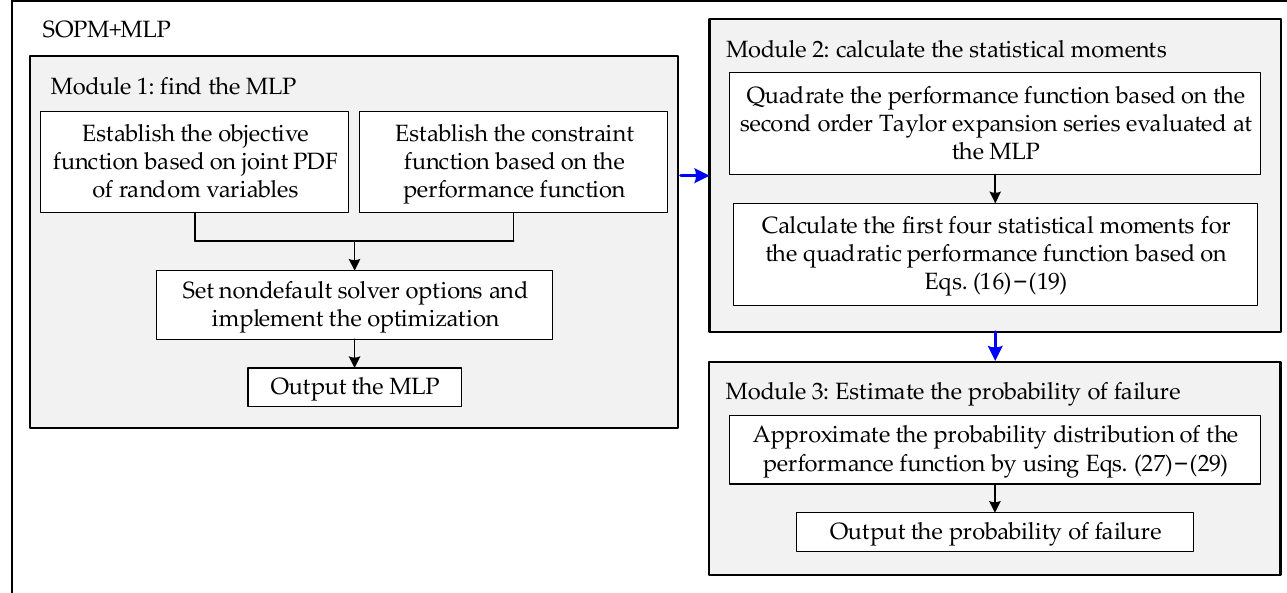
Figure 2. Flowchart of the proposed approach